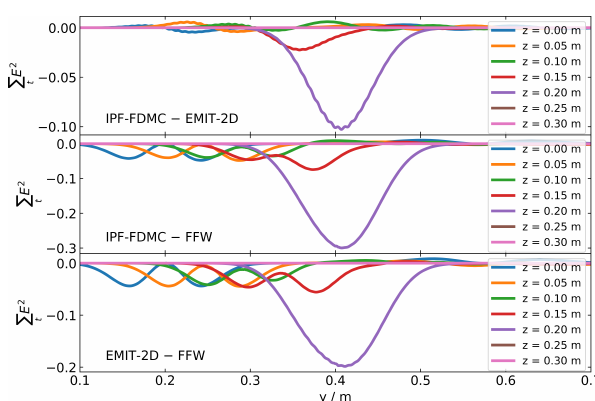
Figure 9. Di ff erence of the detector antenna signals obtained from the full-wave simulations for scenario #6.